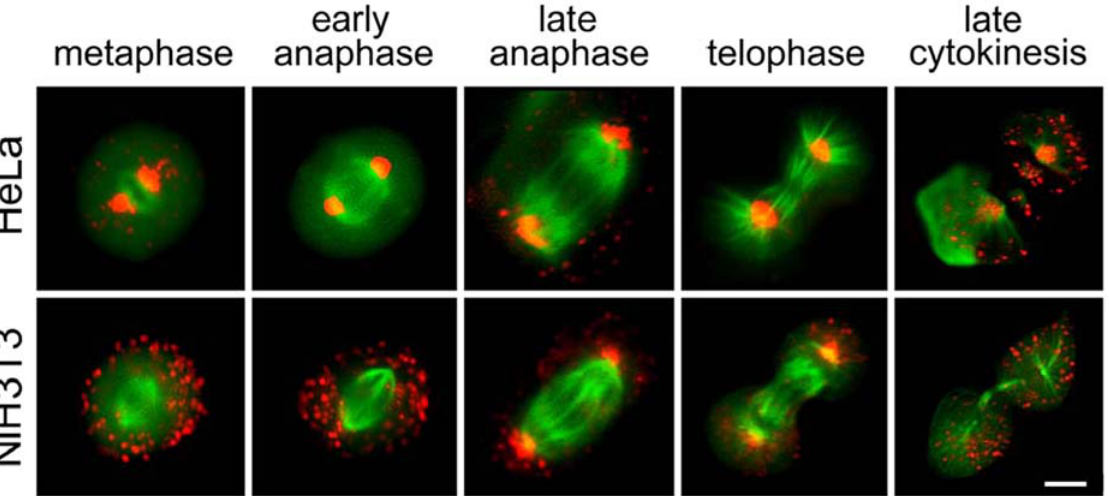
Figure 5. Inheritance of peroxisomes. Distribution of peroxisomes during different stages of mitosis in HeLa (upper row) and NIH3T3 cells (lower row). Peroxisomes are highlighted by mRuby-PTS. The spindle of the mitotic cells is stained with EGFP fused to a tubulin-binding protein [14]. Images were taken 24–48 h after transfection on an Olympus IX71 microscope equipped with standard FITC and TRITC filter sets. Bar: 5 m m.